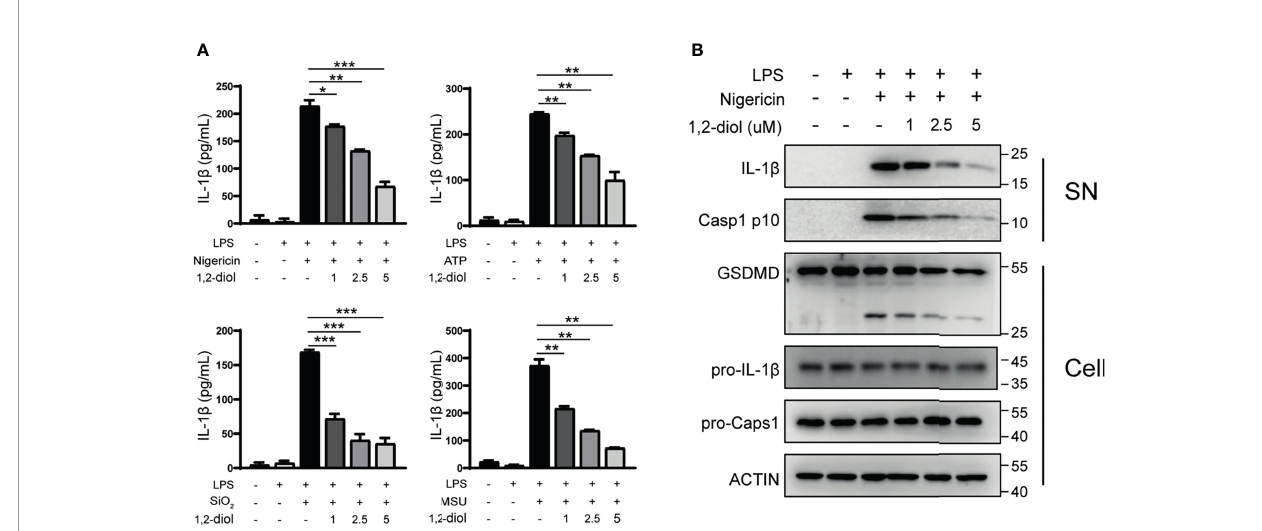
FIGURE 2 | 1,2-Diol suppresses NLRP3 in fl ammasome activation in THP-1 cells. (A) ELISA of IL-1 b in supernatant from PMA-primed THP-1 cells treated with LPS stimulation, after that the cells were treated with or without different doses of 1,2-diol and stimulated with ATP, nigericin SiO 2 or MSU. (B) Western blots for Caspase-1 and IL-1 b in the supernatant or the cleavage of GSDMD, the expression of pro-Caspase-1 and pro-IL-1 b in the cell lysates of PMA-primed THP-1 cells treated with LPS stimulation, after that the cells were treated with or without different doses of 1,2-diol and stimulated with nigericin. (*p < 0.05; **p < 0.01; ***p <